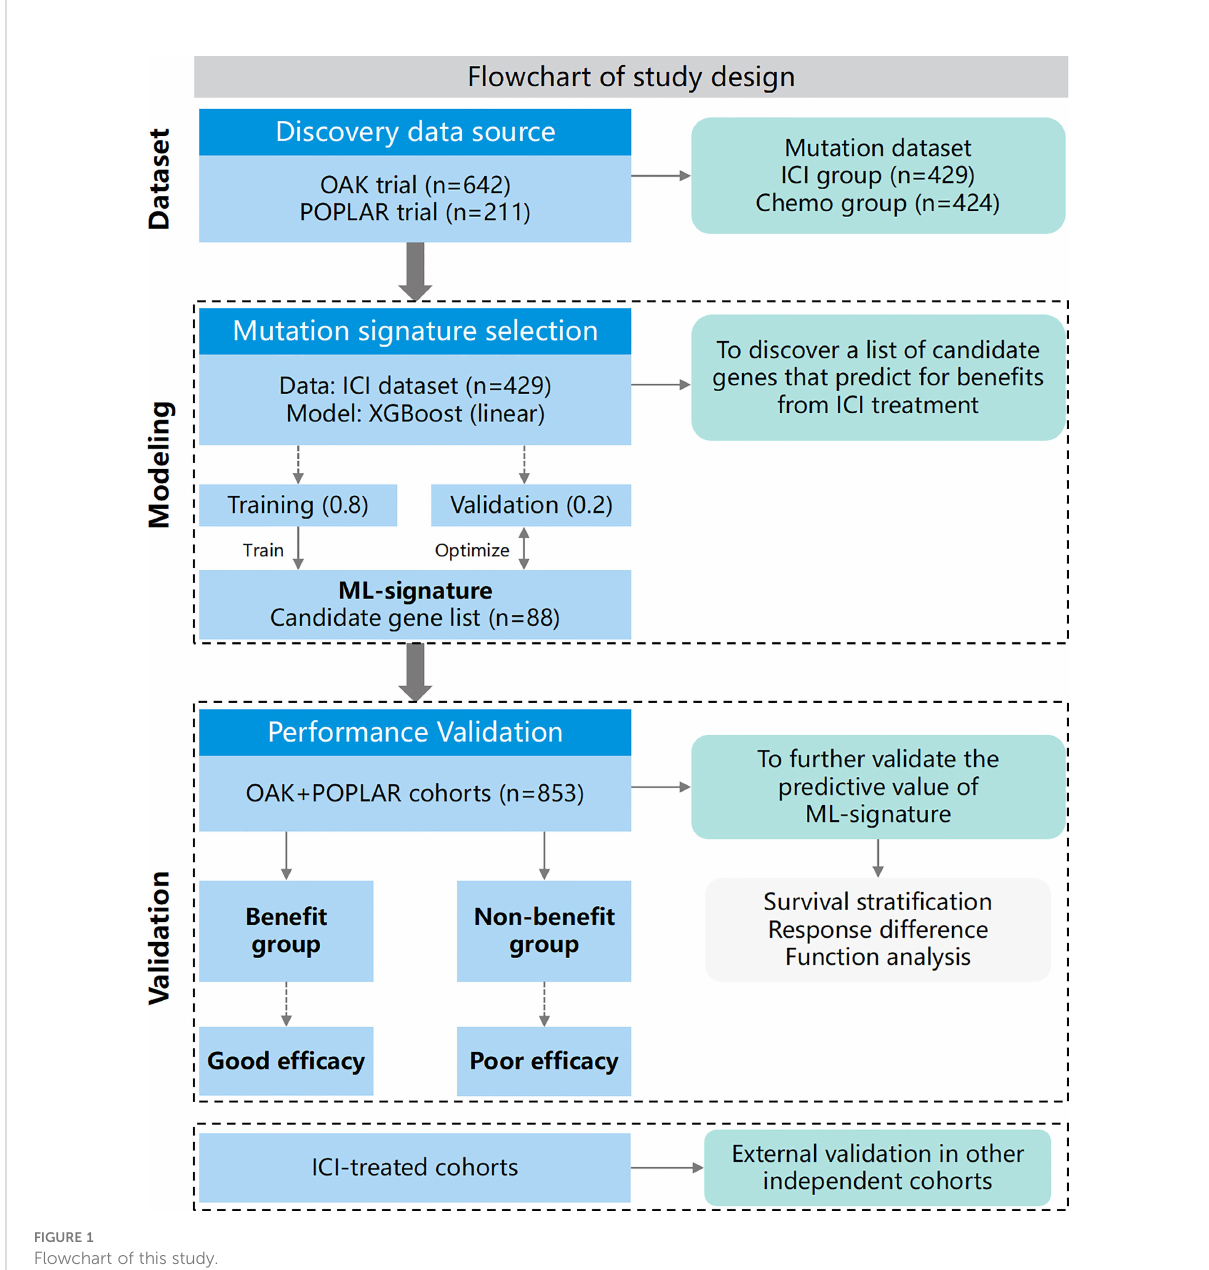
FIGURE 1 Flowchart of this